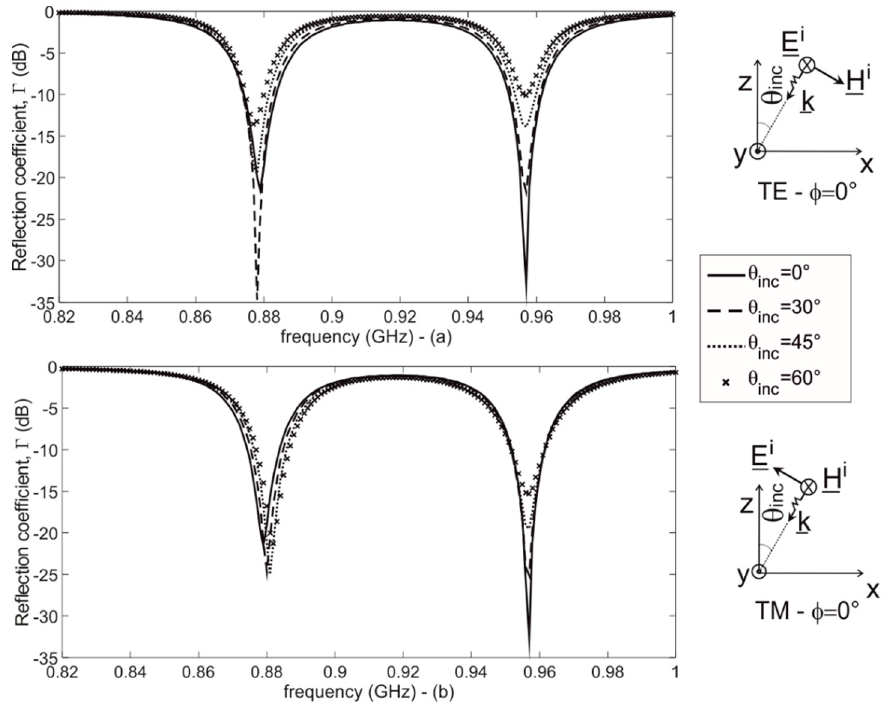
Figure 4. Reflection coefficient vs. frequency of the synthesized dual-band metamaterial absorber (MA) cell for different incidence angles ( ε r = 4.2, tan δ = 0.015 and h = 3.2 mm–D ≅ 0.4 λ @ f 1 ): ( a ) TE-polarization ( b ) TM-polarization. Table 1. Comparison with previously proposed dual-band MAs.